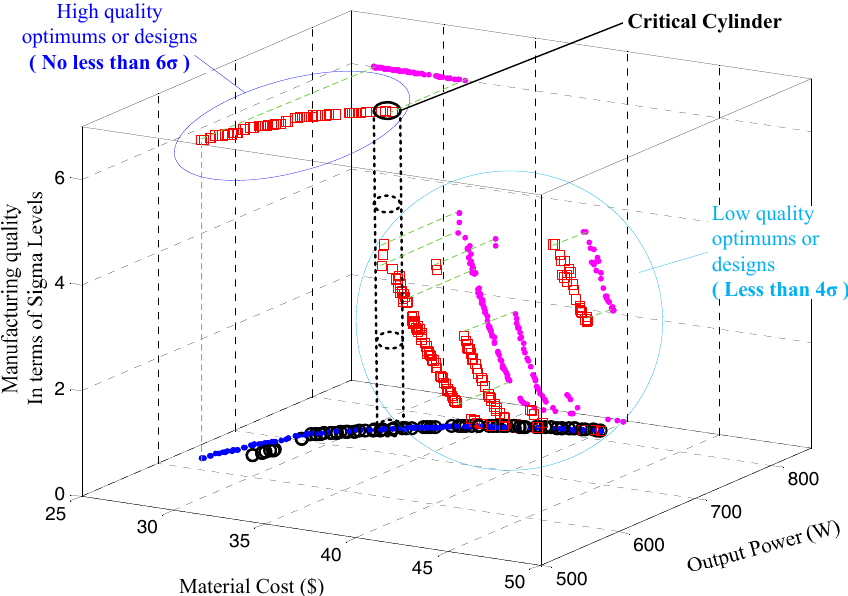
Figure 14. Illustration of design optimization for 6 σ manufacturing quality.